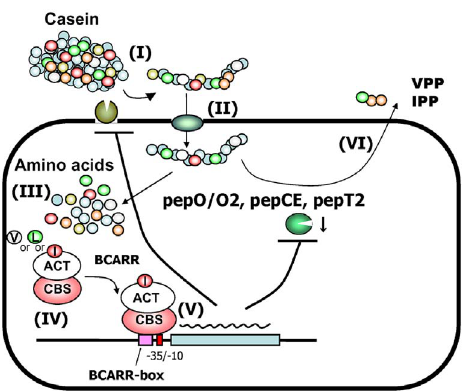
Figure 9. Model for the regulation of the proteolytic system of L.helveticus by the BCARR protein. Release of the long peptide containing VPP and IPP sequences by an extracellular proteinase (I), uptake of the long peptide via oligopeptide transporter (II), intracellular processing of the peptides to amino acids by peptidases (III), BCARR (ACT domain)-BCAA complex formation (IV), binding of the complex (CBS domain) to the BCARR-box and repression of proteolysis gene transcription (V) and repressed release of the antihypertensive peptides, VPP and IPP (VI). L; Leucine, I; Isoleucine, V; Valine. T arrows indicate repressive